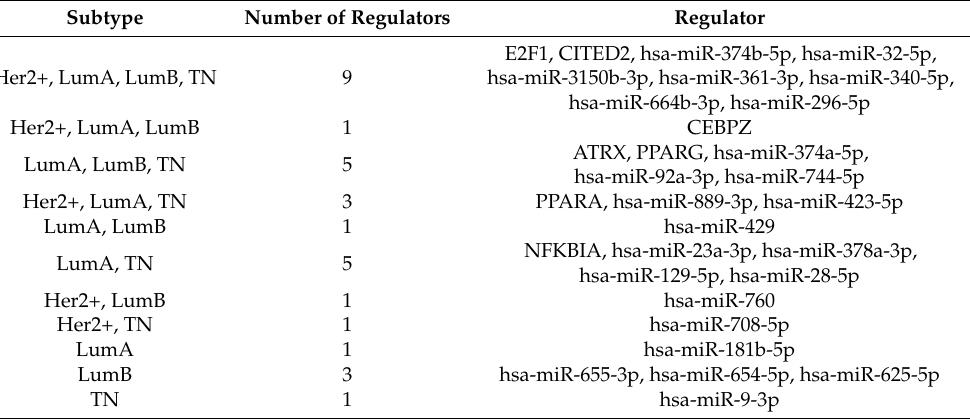
Table 2. Selected common and subtype-specific